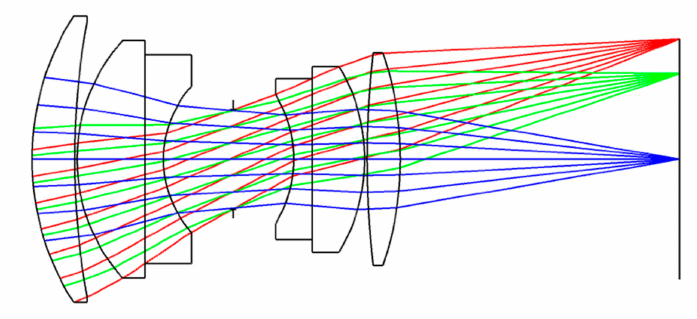
Figure A1. Beam path of a Double Gauss